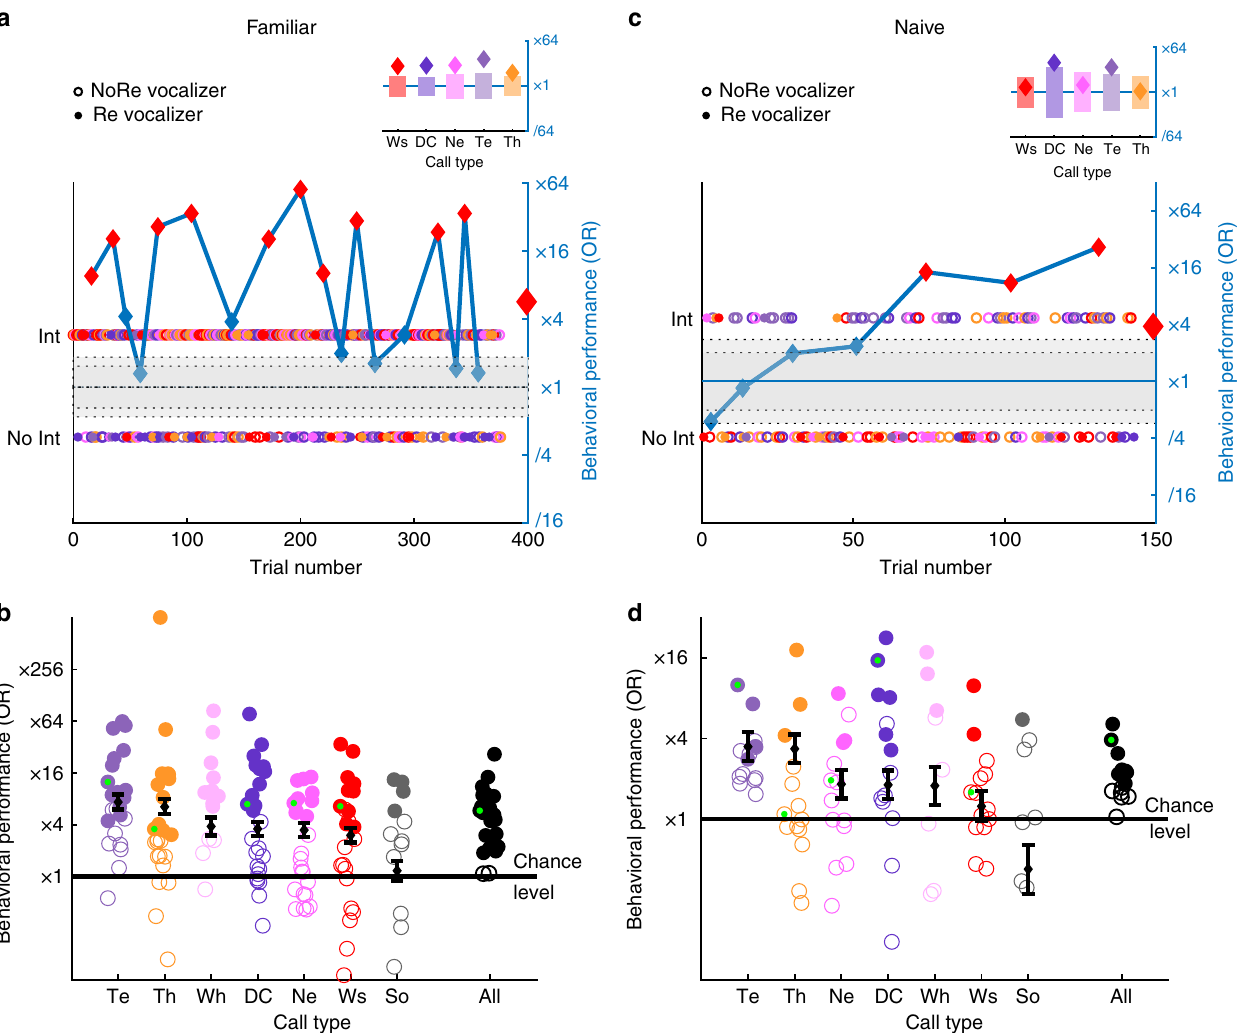
Fig. 6 Behavioral generalization across call types. Familiar subjects ( a and b ) were tested in the all-call-type tests with the same vocalizers as in previous single-call-type tests. Naive subjects ( c and d ) performed the discrimination between vocalizers they had never heard before. a − c One bird subject performance at discriminating two female vocalizers across fi ve call types (color coded as in Fig. 4a) and multiple renditions within each call type (all-call- type test; a n = 313 and c n = 214 renditions). Each dot corresponds to a stimulus. The behavioral performance as measured by the odds ratio (OR, see Fig. 1) is given by the blue line. Red diamonds indicate an OR value signi fi cantly different from 1. The gray areas depict the 5 − 95% and 1 − 99% quantiles for a random odds ratio for all trials. The insert shows the OR calculated for each call type across the entire test (diamonds) with the 5 − 95% con fi dence intervals for a random interruption behavior (bars). b − d Behavioral performance of all subjects ( b n = 13; d n = 7) in the all-call-type test (effect of vocalizer, LRT on GLME: b χ 2 1 = 397.2, p = 0, d χ 2 1 = 55, p = 1.2068×10 − 13 ; effect of call type, LRT on GLME: b χ 2 6 = 247.7, p = 0, d χ 2 6 = 172.4, p = 0). Black diamonds and error bars correspond to the estimates of the GLME coef fi cients and their 95% con fi dence intervals. Filled circles indicate OR signi fi cantly above chance tested by exact test as described in Methods. Call type is color coded as described in Fig. 4a. The category All corresponds to the behavioral performance (OR) when all stimuli are considered, irrespective of the call type. OR performance for the subjects shown in a and c is identi fi ed by a small green dot in b and